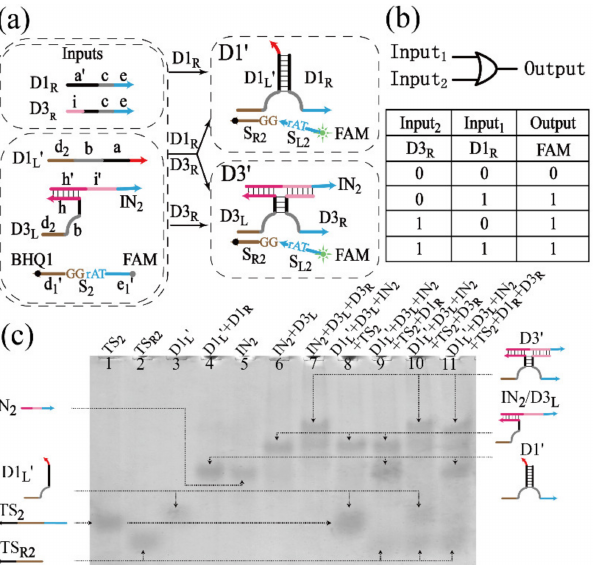
Figure 2. ( a ) Schematic diagram of the OR gate. ( b ) Truth table and logical operations of the OR gate. ( c ) PAGE gel of the OR gate. Lane 1, substrate TS 2 ; lane 2, DNA strand TS R2 ; lane 3, DNA strand D1 L ’; lane 4, the annealing of the mixture of D1 L ’ and D1 R ; lane 5, DNA strand IN 2 ; lane 6, the mixture of IN 2 and D3 R ; lane 7, the mixture of IN 2 , D3 L and D3 R ; lane 8, the initial state of OR gate: the